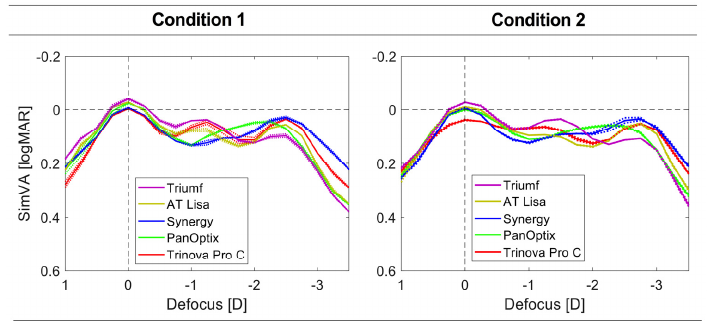
Figure 3. The simulated visual acuity (SimVA) of the trifocal IOLs was derived from optical assess- ment at 3 mm under two conditions: Condition 1 had the lenses tested in monochromatic light with an aberration-neutral corneal model. Condition 2 used polychromatic light which had a population level of corneal spherical aberration. The dotted lines show the values of each lens separately; the solid lines refer to the average of two samples.